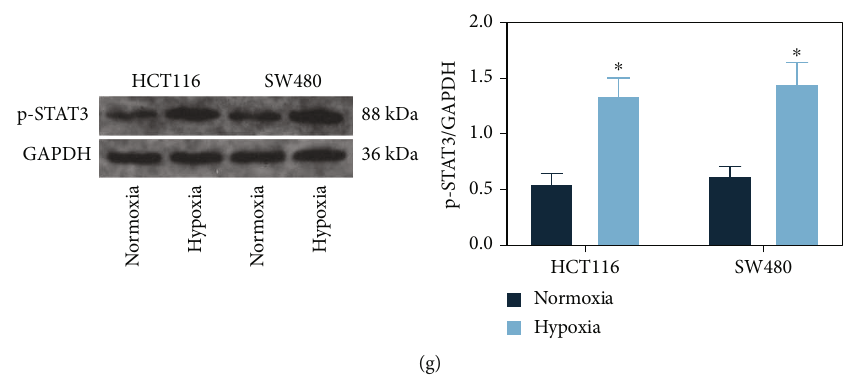
Figure 3: STAT3 activates transcription activity of miR-19a in the hypoxia-exposed CRC cells: (a) possible upstream regulators of miR-19a predicted using TransmiR v2.0; (b) fi ve segments of miR-19a promoter divided from the distal side to near side; (c) luciferase activity of the miR-19a promoter segments in HEK293T cells after hypoxia exposure ( ∗ p < 0 : 05 , two-way ANOVA); (d) binding relationship between STAT3 and the miR-19a promoter validated using a ChIP-qPCR assay ( ∗ p < 0 : 05 , two-way ANOVA); (e) mRNA expression of STAT3 in tumor tissues and the paracancerous tissues examined by RT-qPCR; (f) a positive correlation between STAT3 and miR-19a in CRC tumor tissues ( ∗ p < 0 : 05 , Pearson ’ s correlation analysis); (g) phosphorylation of STAT3 in HCT116 and SW480 cells after hypoxia exposure examined by western blot analysis. Data were presented as the mean ± SD from three independent